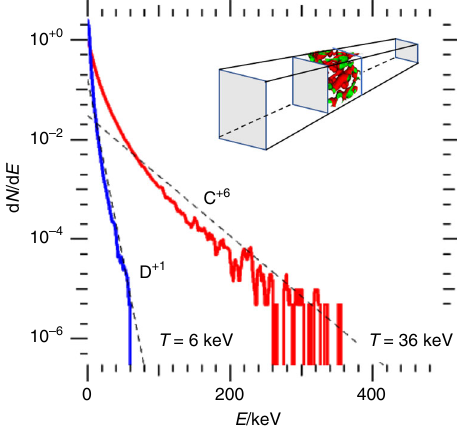
Fig. 3 Result of a CD nanofoam explosion. Particle energy spectra of carbon (red) and deuterium (blue) ions from a 3-D particle-in-cell simulation of a laser-driven encapsulated CD nanofoam target, as illustrated in the inset. Dashed lines are exponential fi ts to the